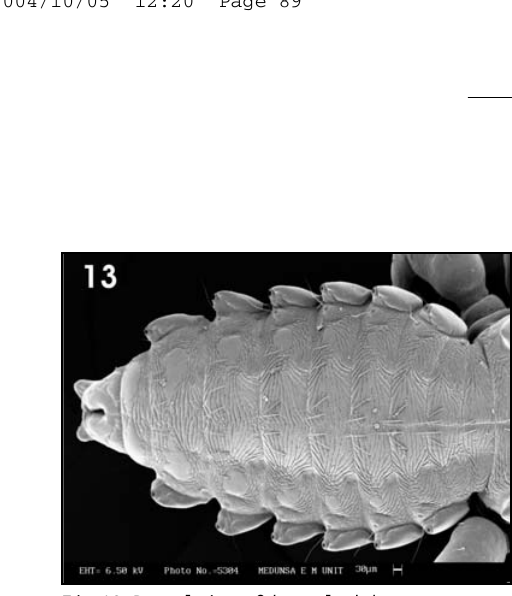
Fig. 13. Dorsal view of the male abdomen.